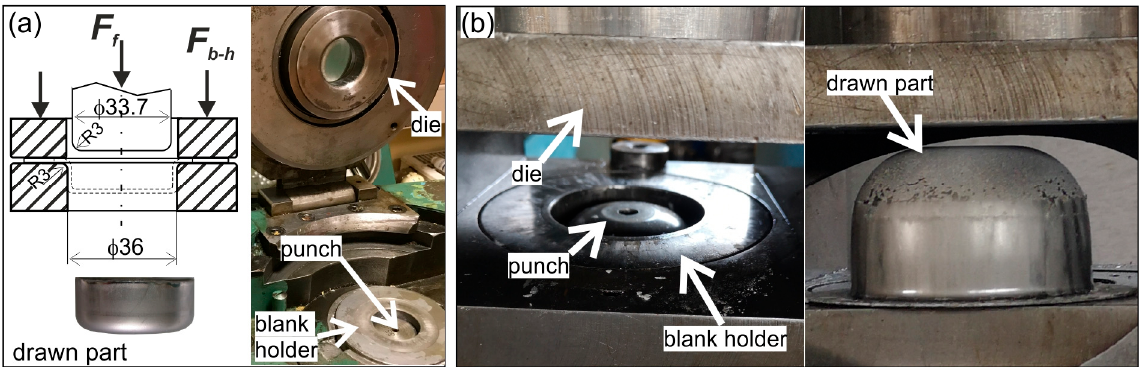
Figure 2. Forming of: ( a ) cylindrical drawn part ( F f —forming force, F b-h —blank holder force); ( b ) hat-shaped part. Table 1. Nominal chemical composition of Grade 2 and Grade 5 titanium. Element, wt.%